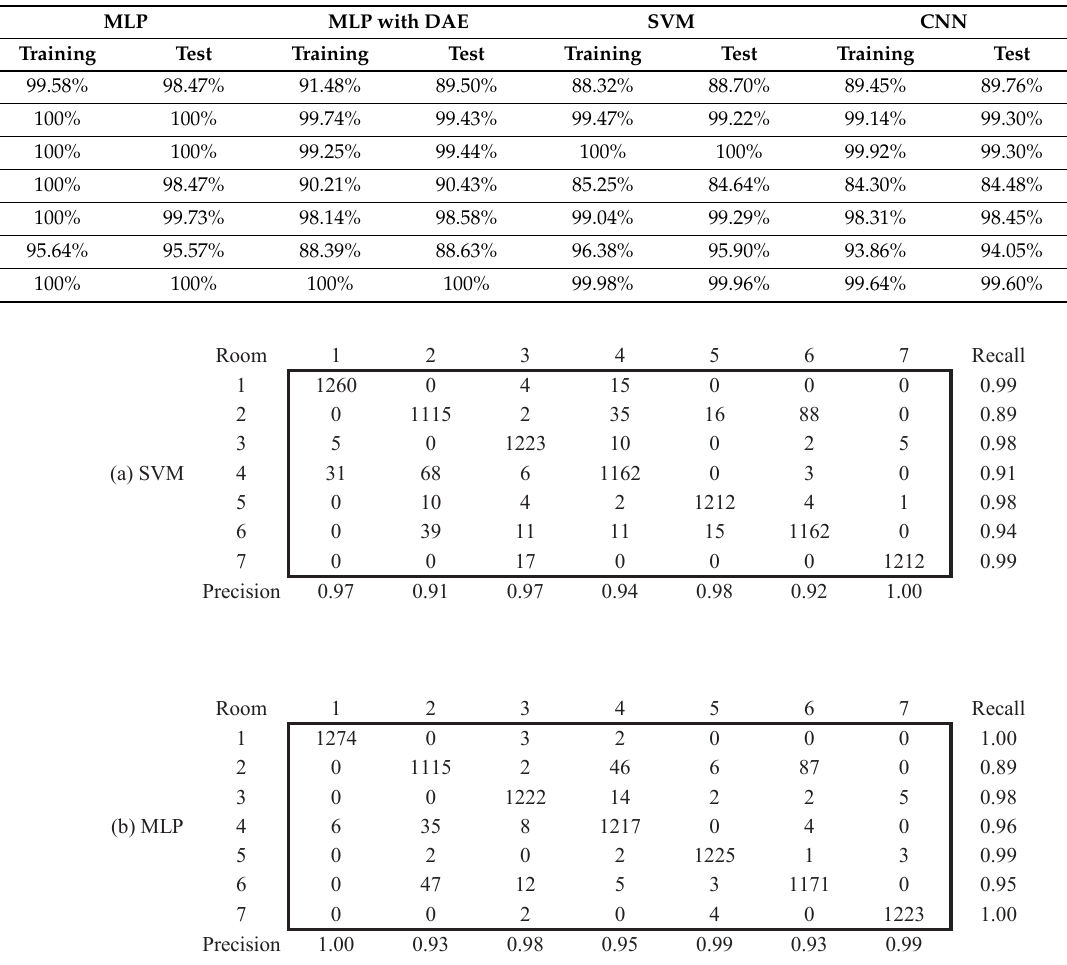
Table 2. Prediction accuracy for S 1 activities in machine learning schemes.